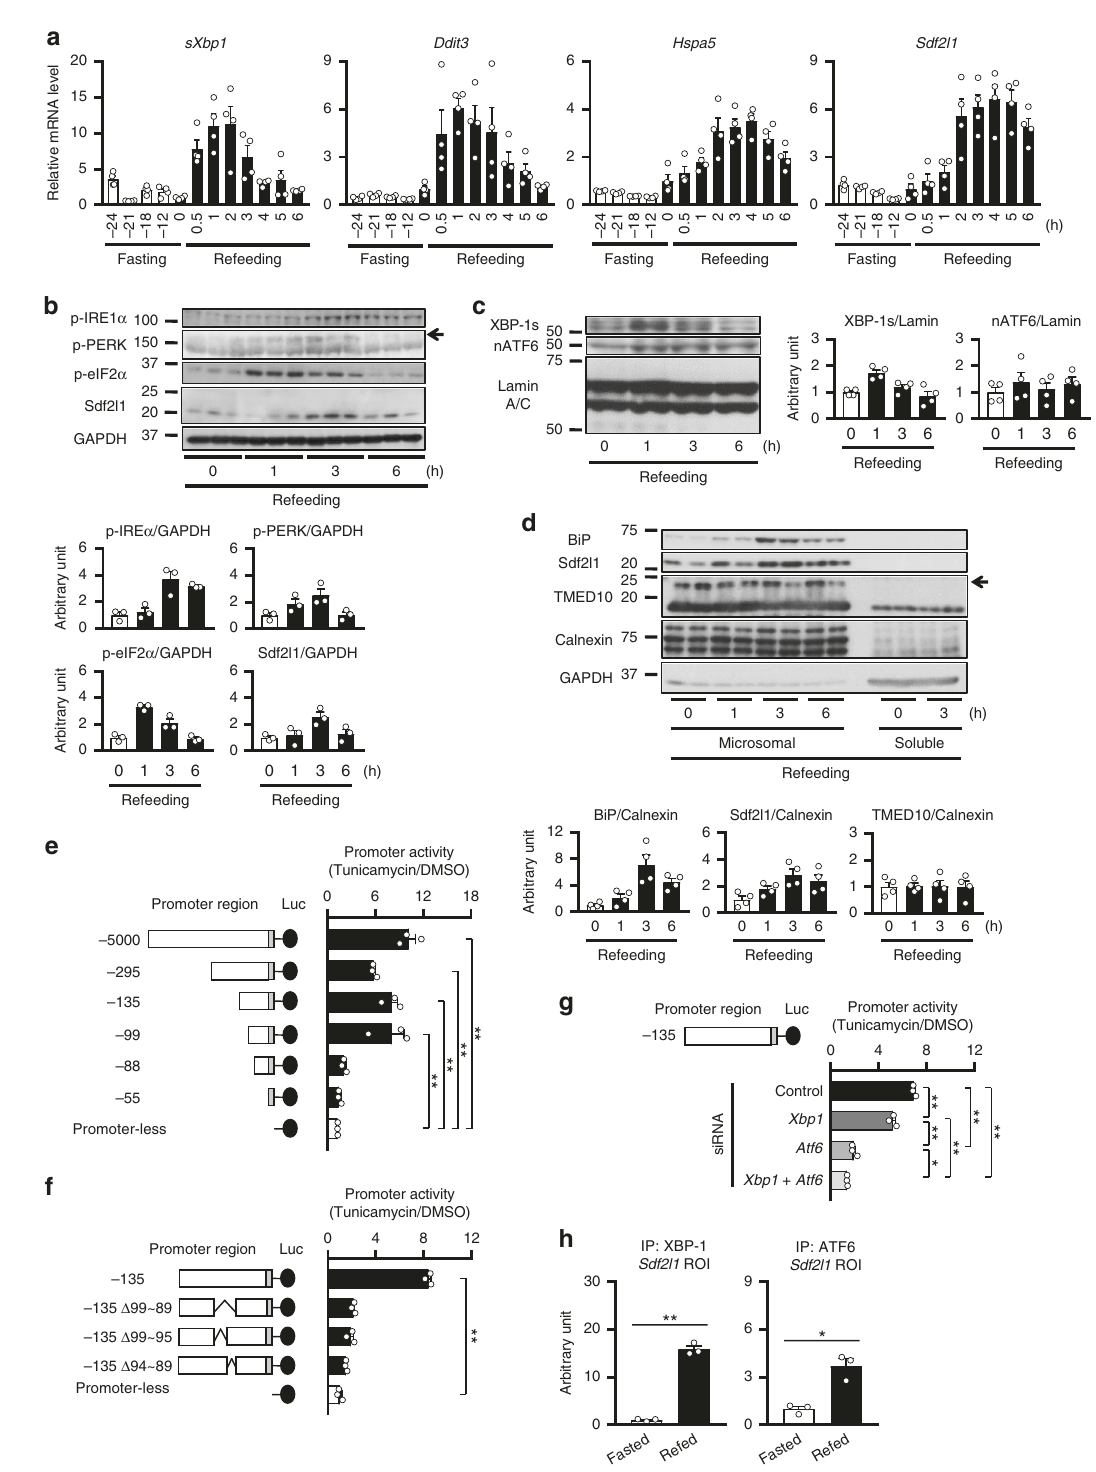
Fig. 1 ER stress induced by feeding in the liver and regulation of Sdf2l1 expression. a – d C57BL/6J mice in an ad libitum-fed state were fasted for 24 h and then refed for 6 h, and ER stress markers were analyzed by a RT-PCR ( n = 4), b Western blotting of total lysates ( n = 3), c Western blotting of nuclear extracts (XBP-1s and nATF6 were detected at 55 and 50 kDa, respectively) ( n = 4), and d Western blotting of microsomal fractions ( n = 4). e – g Sdf2l1 promoter assays in Fao cells by transfecting luciferase (Luc) plasmids, with tunicamycin treatment, assessed with one-way ANOVA ( n = 3), e using deletion mutants of upstream sequences, f using partial or total deletion mutants of the 11 bases of interest, and g using reporter plasmids, with knocking down of Xbp1 and/or Atf6 . h ChIP assay, using antibodies recognizing XBP-1 or ATF6, for analysis of binding with the Sdf2l1 promoter in the liver, in a 24-h fasted state and a 3-h refed state ( n = 3). The relative expression levels were normalized by the upstream region ( − 3.5 kb) and then by control IgG (rabbit or mouse IgG, respectively). Values of the data are expressed as mean ± SEM. * P < 0.05, ** P < 0.01. Unpaired 2-tailed t -test was used for